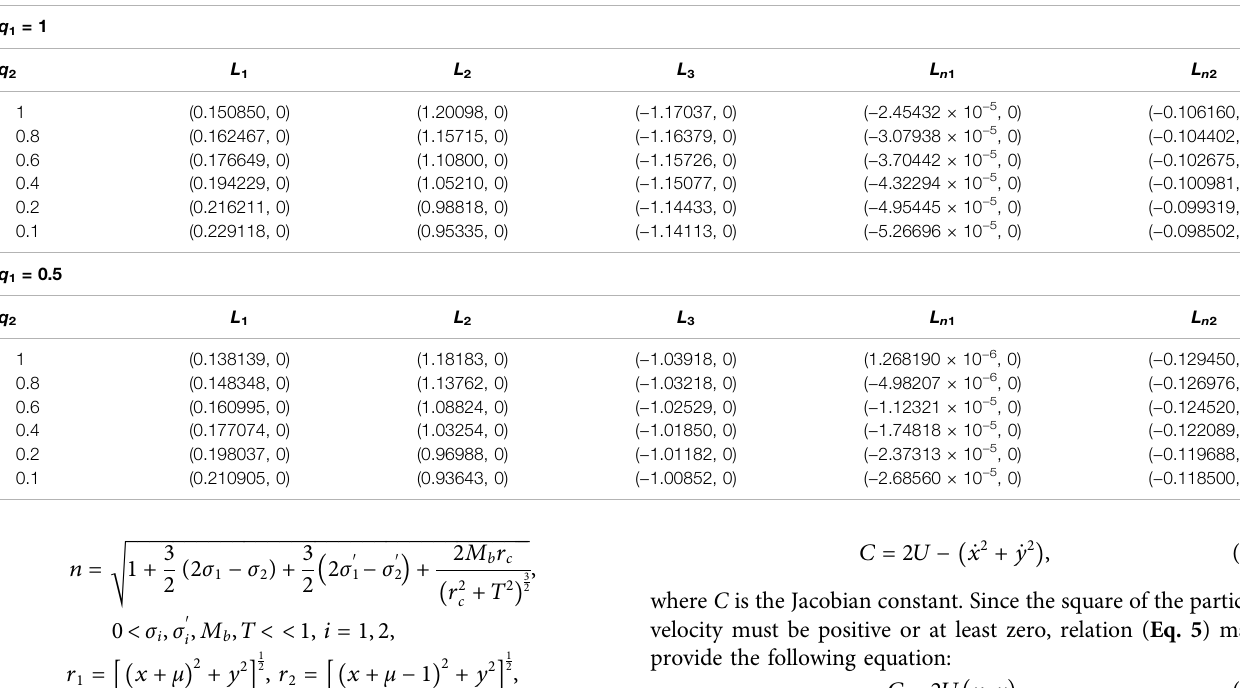
TABLE 2 | Positions ( x 0 , 0) of the collinear points of the binary HD155876 system for the fi xed values M b = 0.05, T = 0.01, σ 1 = 4 × 10 − 5 , σ 2 = 3 × 10 − 5 , σ 1 ′ (cid:1) 2 × 10 − 5 , ′ (cid:1) 10 − 5 , A σ fi xed values of q 2 3 = 0.02, and for two 1 when q 2